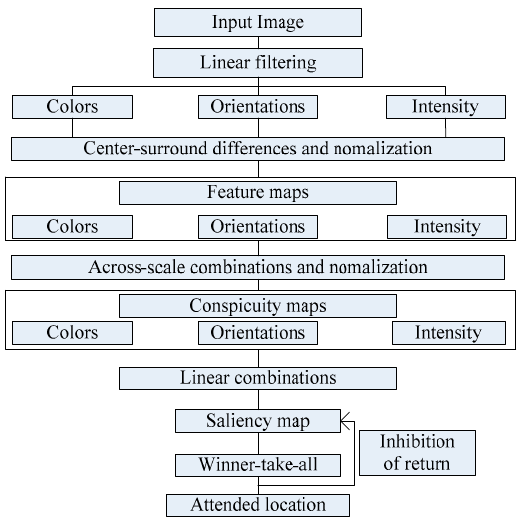
Figure 1. General architecture of the model.